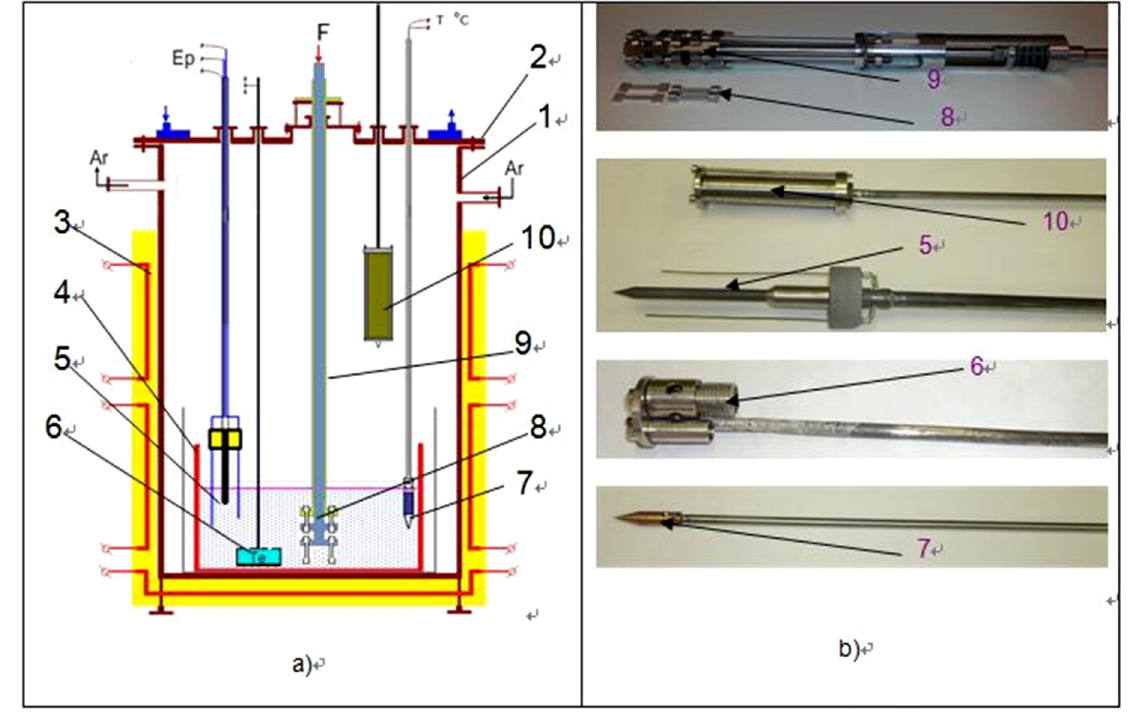
Fig. 1. Corrosion facility layout (a) and its main components (b): 1 – high temperature furnace, 2 – furnace cover, 3 – electric heaters, 4 – NP2 nickel vessel, 5 – device for measuring redox potential, 6 – container for tellurium metal or nickel di fl uoride, 7 – sampler and thermocouple, 8 – alloy specimens, 9 – stick providing mechanical load on metallic specimens, 10 – beryllium